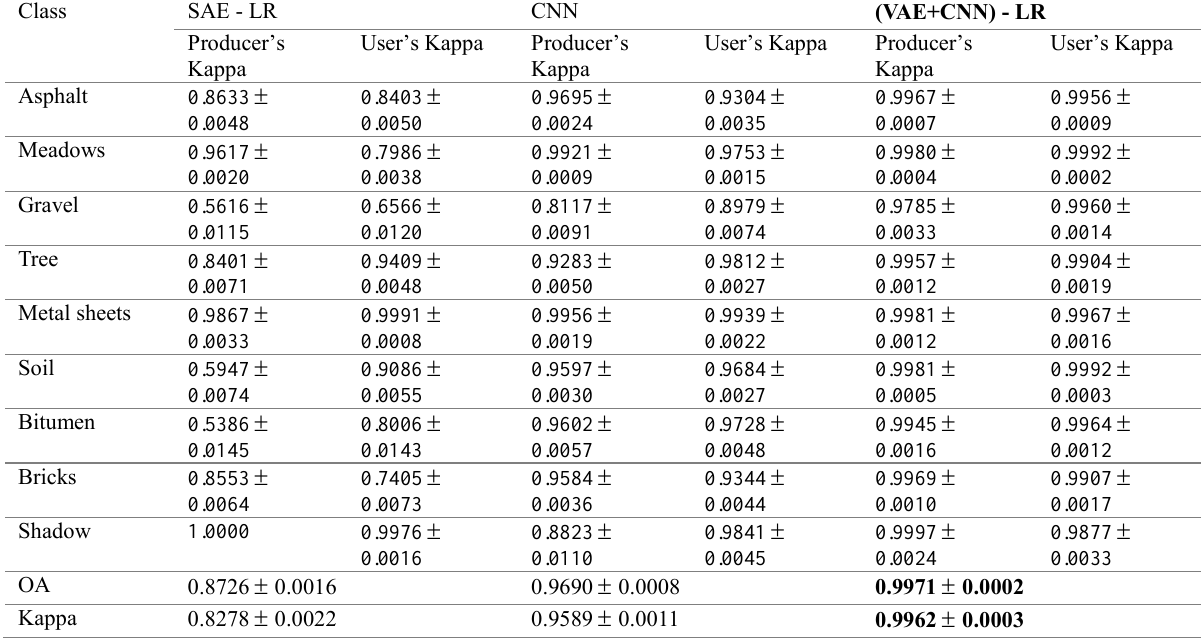
Table 2. Class-wise accuracies of the University of Pavia (PU)